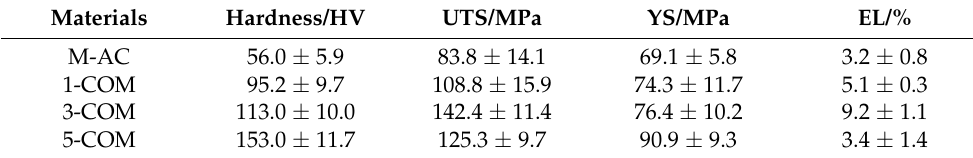
Figure 9. Typical tensile engineering stress-strain curves of the alloys and the composites. Table 1. Mechanical properties of the alloys and the composites.